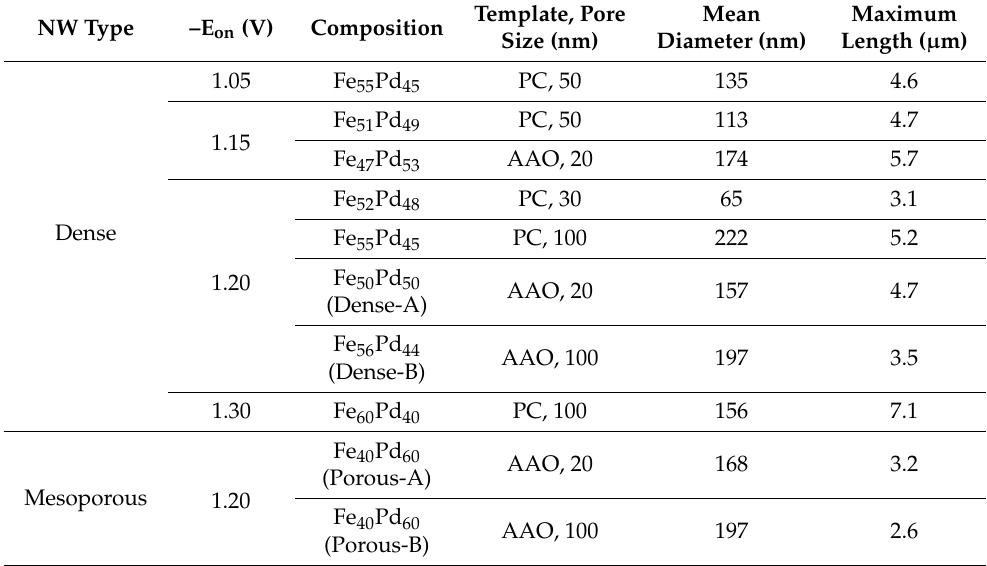
Table 1. E on values used for the growth of dense and mesoporous FePd NWs, the resulting chemical composition, template used, mean diameter, and maximum length.